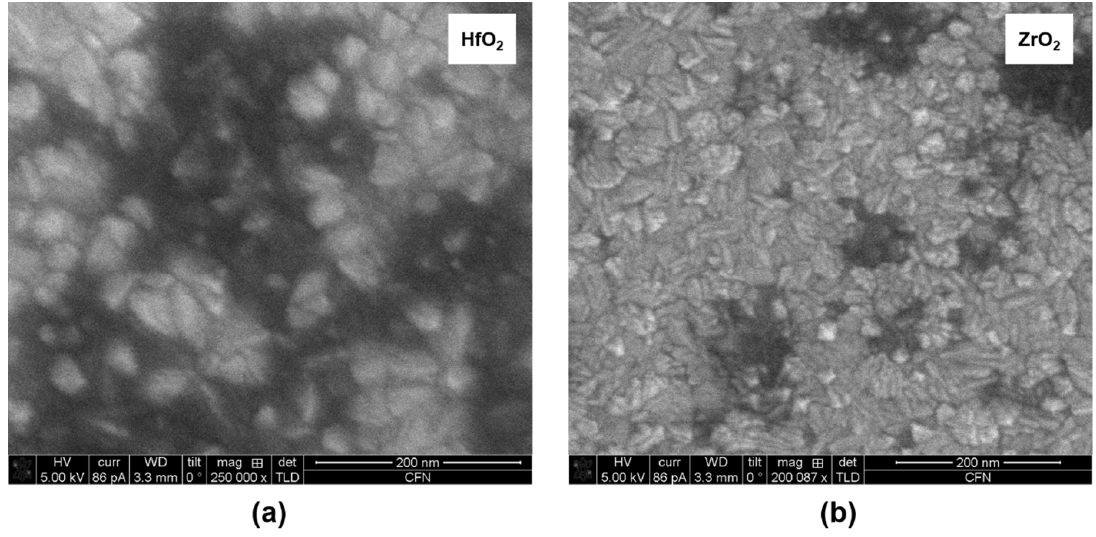
Figure 5. ( a ) SEM image of the HfO 2 thin film; ( b ) SEM image of the ZrO 2 thin